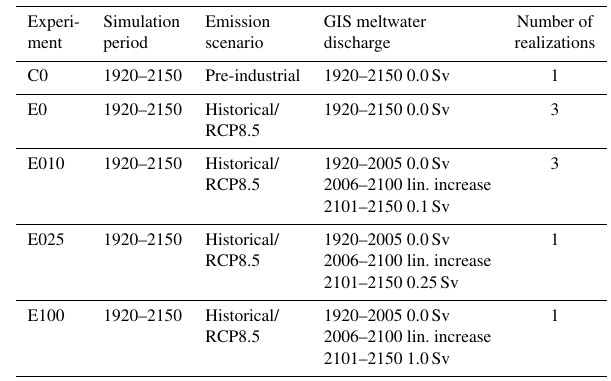
Table 1. Overview of the experimental setup. Each realization has been performed with the global Earth system model MPI-ESM-LR and dynamically downscaled with the regionally coupled ocean– atmosphere climate system model MPIOM/HAMOCC/REMO.